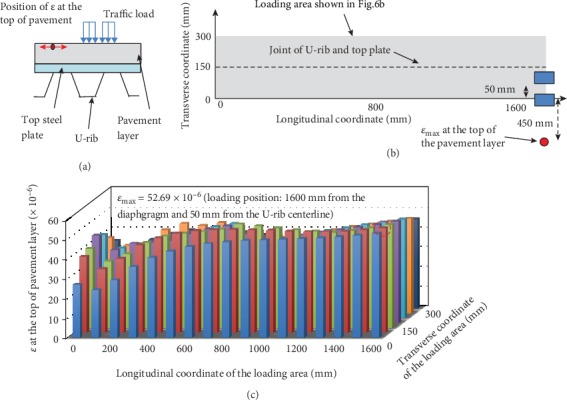
(a) The location of ε, (b) the location of εmax and the corresponding loading position, and (c) the change of ε with the change of loading positions.